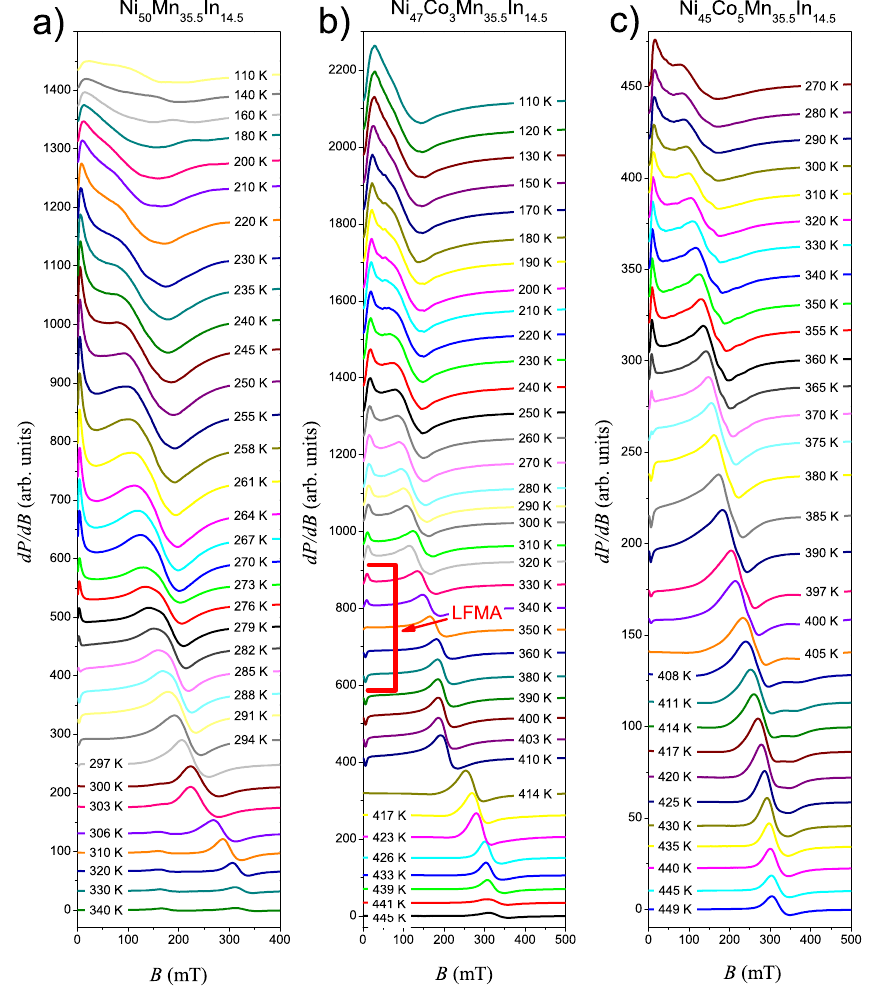
Figure 3. Selected EMR spectra of derivative of the resonance absorption ( dP / dB ) for Ni 50 − x Co x Mn 35.5 In 14.5 ribbons: Ni 50 Mn 35.5 In 14.5 r ( a ), Ni 47 Co 3 Mn 35.5 In 14.5 ( b ) and Ni 45 Co 5 Mn 35.5 In 14.5 ( c ) reg- istered during a cooling process. Spectra are vertically shifted for clarity. The example of the LFMA signal is marked in